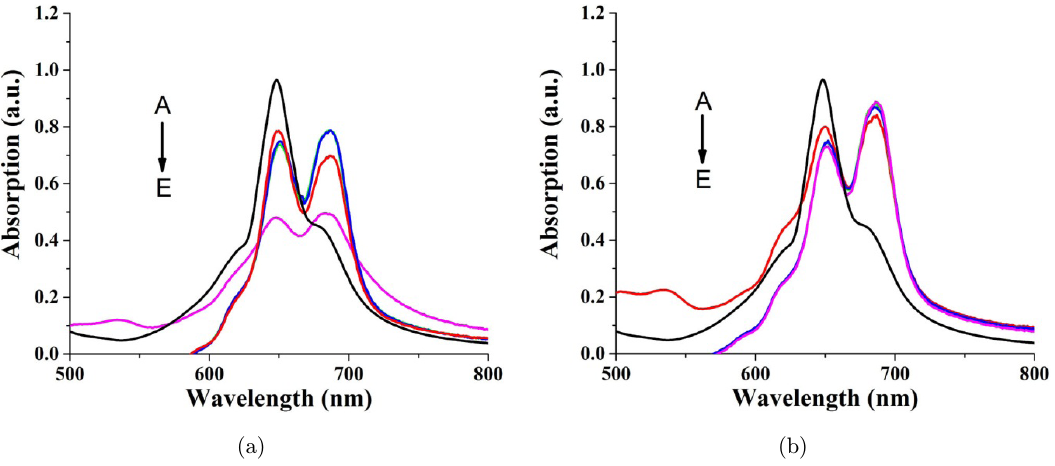
Fig. 6. E®ects of HE, IB and TRP on absorption spectra of AlPc-HSA system. (a) The AlPc/HSA ratio is 1/1. A – E represents AlPc (black, 1 (cid:1) 10 (cid:2) 5 mol/L), AlPc þ HSA þ IB (red, 1:1:20), AlPc þ HSA þ TRP (blue, 1:1:1000), AlPc þ HSA (green, 1:1) and AlPc þ HSA þ HE (pink, 1:1:20). (b) The AlPc/HSA ratio is 1/10. A – E represents AlPc (black, 1 (cid:1) 10 (cid:2) 5 mol/L), AlPc þ HSA þ HE (red, 1:10:20), AlPc þ HSA þ IB (blue, 1:10:20), AlPc þ HSA þ TRP (green, 1:10:1000) and AlPc þ HSA (pink,